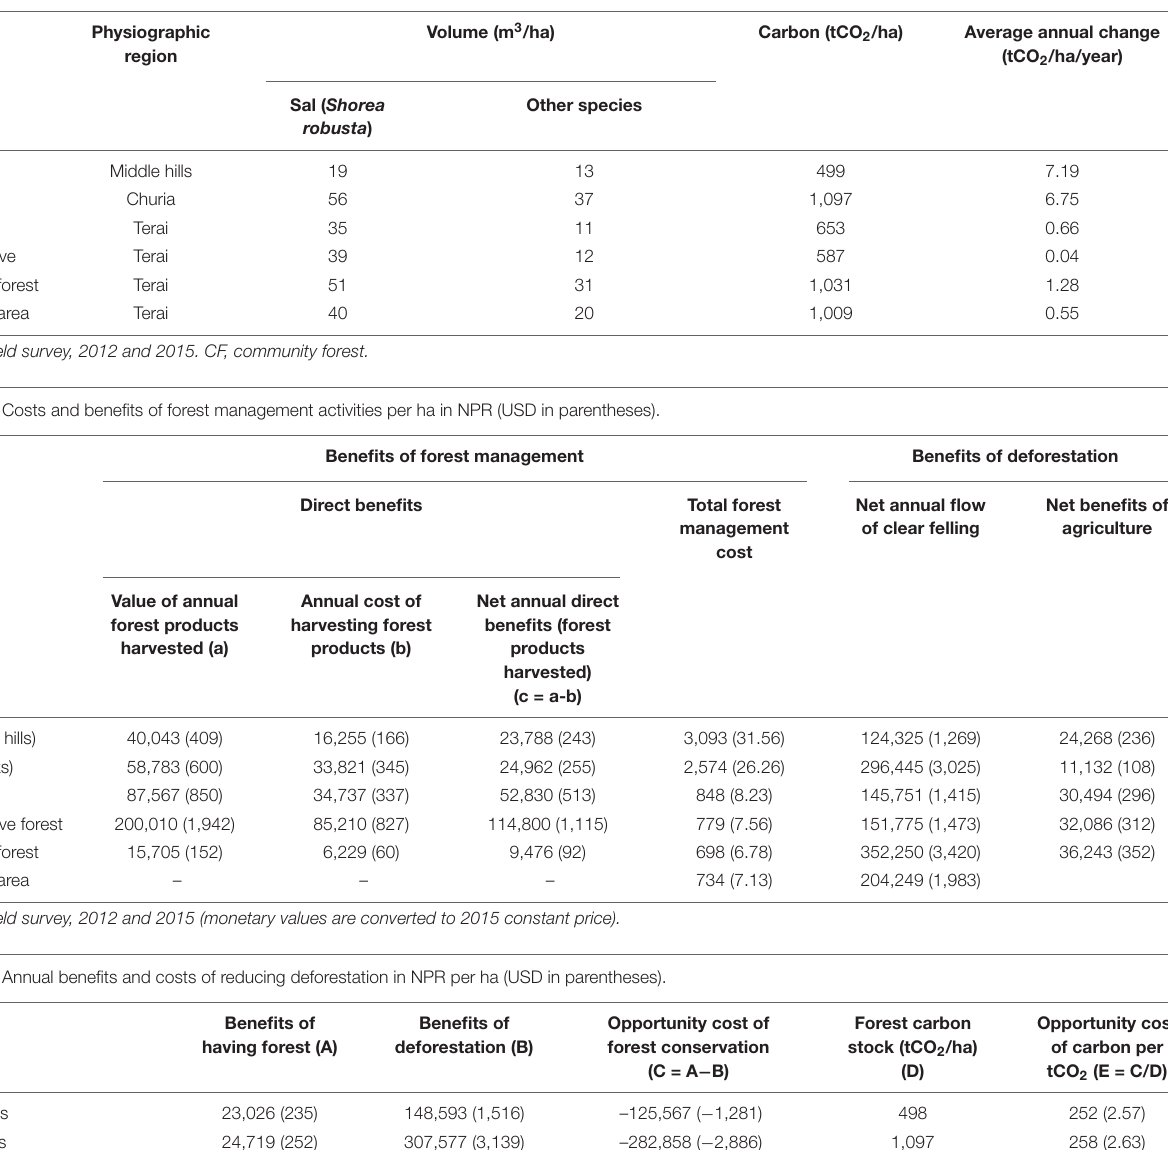
TABLE 1 | Forest growing stock and carbon stock.